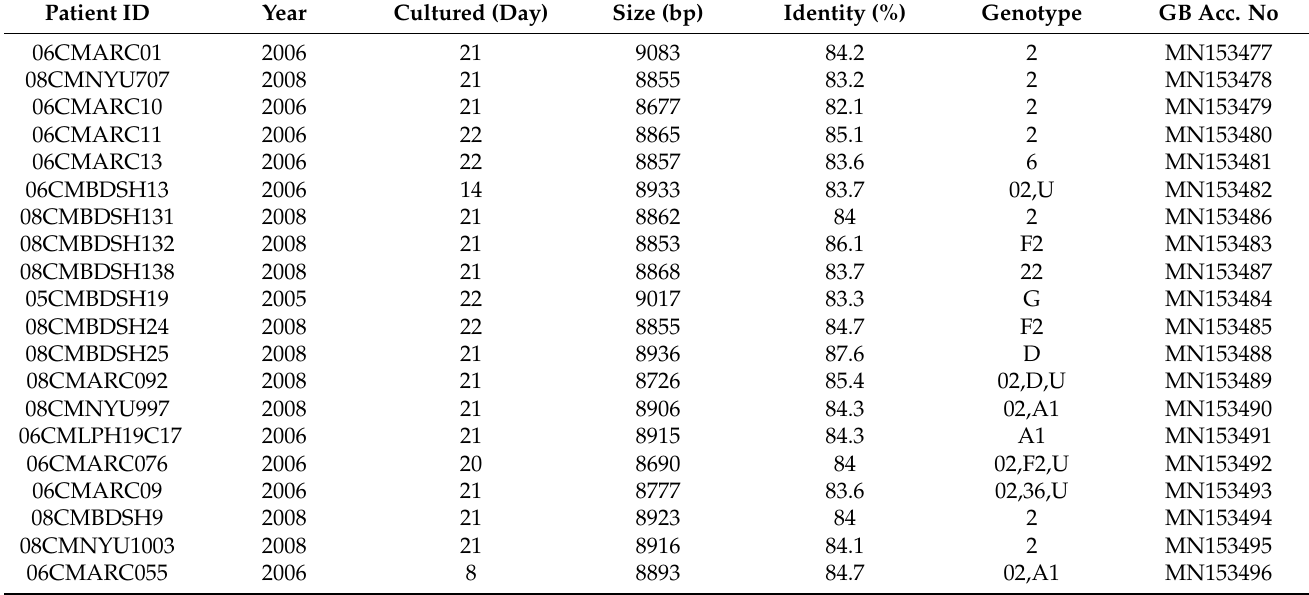
Table 2. Characterized near full-length HIV-1 genomic